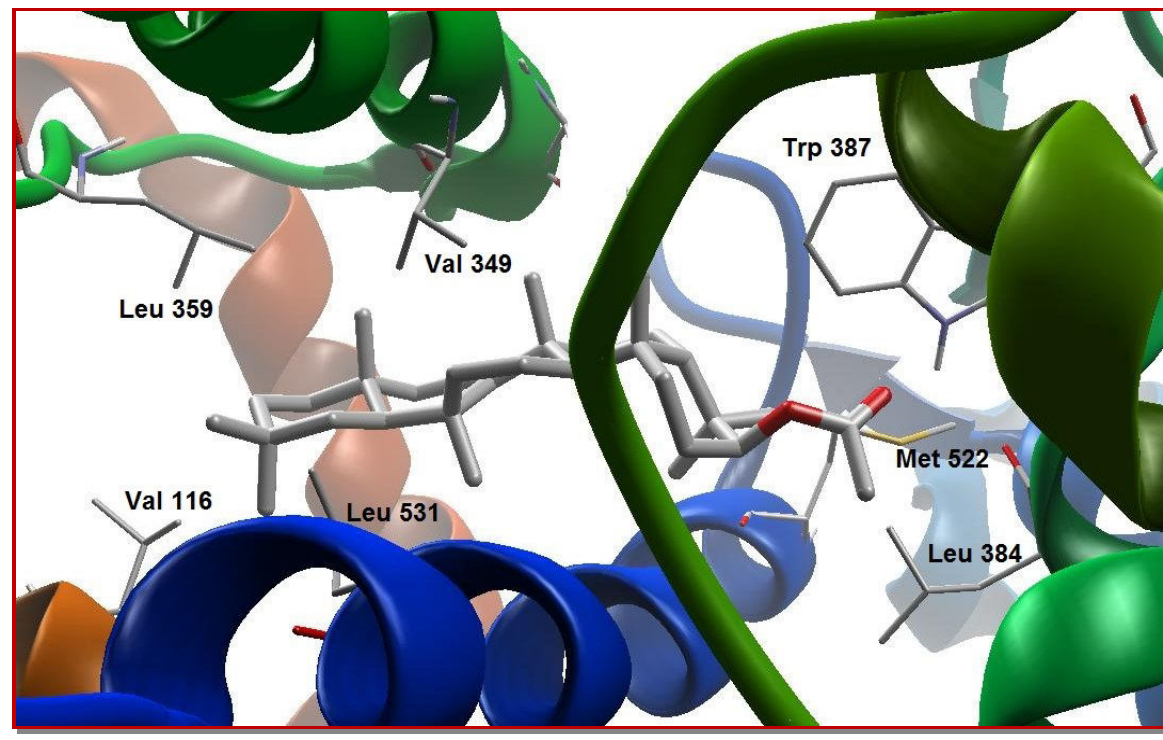
Figure 2: Molecular binding mode of taraxerol acetate inside active site of COX-2